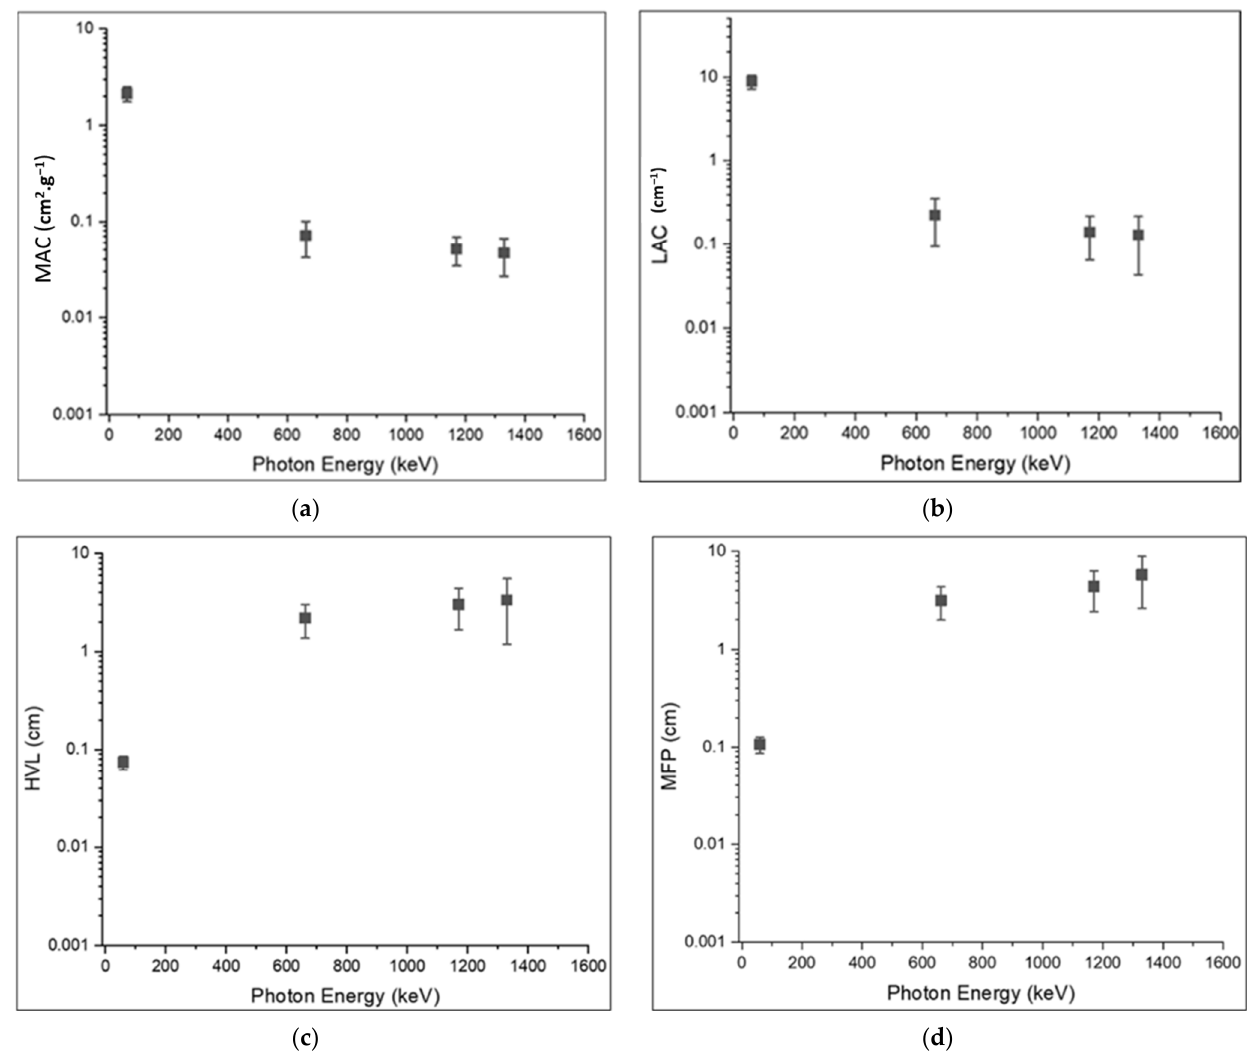
Figure 7. The measured and theoretical shielding parameters for TeTaNbZn glass samples at 59.5, 622, 1170 and 1330 keV: ( a ) MAC; ( b ) LAC; ( c ) HVL; and ( d ) MFP. 622, 1170 and 1330 keV: ( a ) MAC; ( b ) LAC; ( c ) HVL; and ( d )